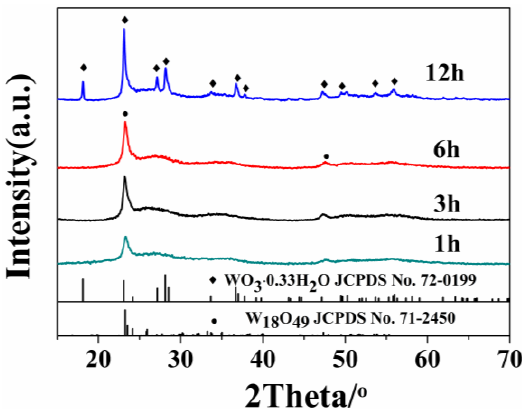
Figure 1. X-ray powder diffractometer (XRD) patterns of the products prepared under different solvothermal reaction times.